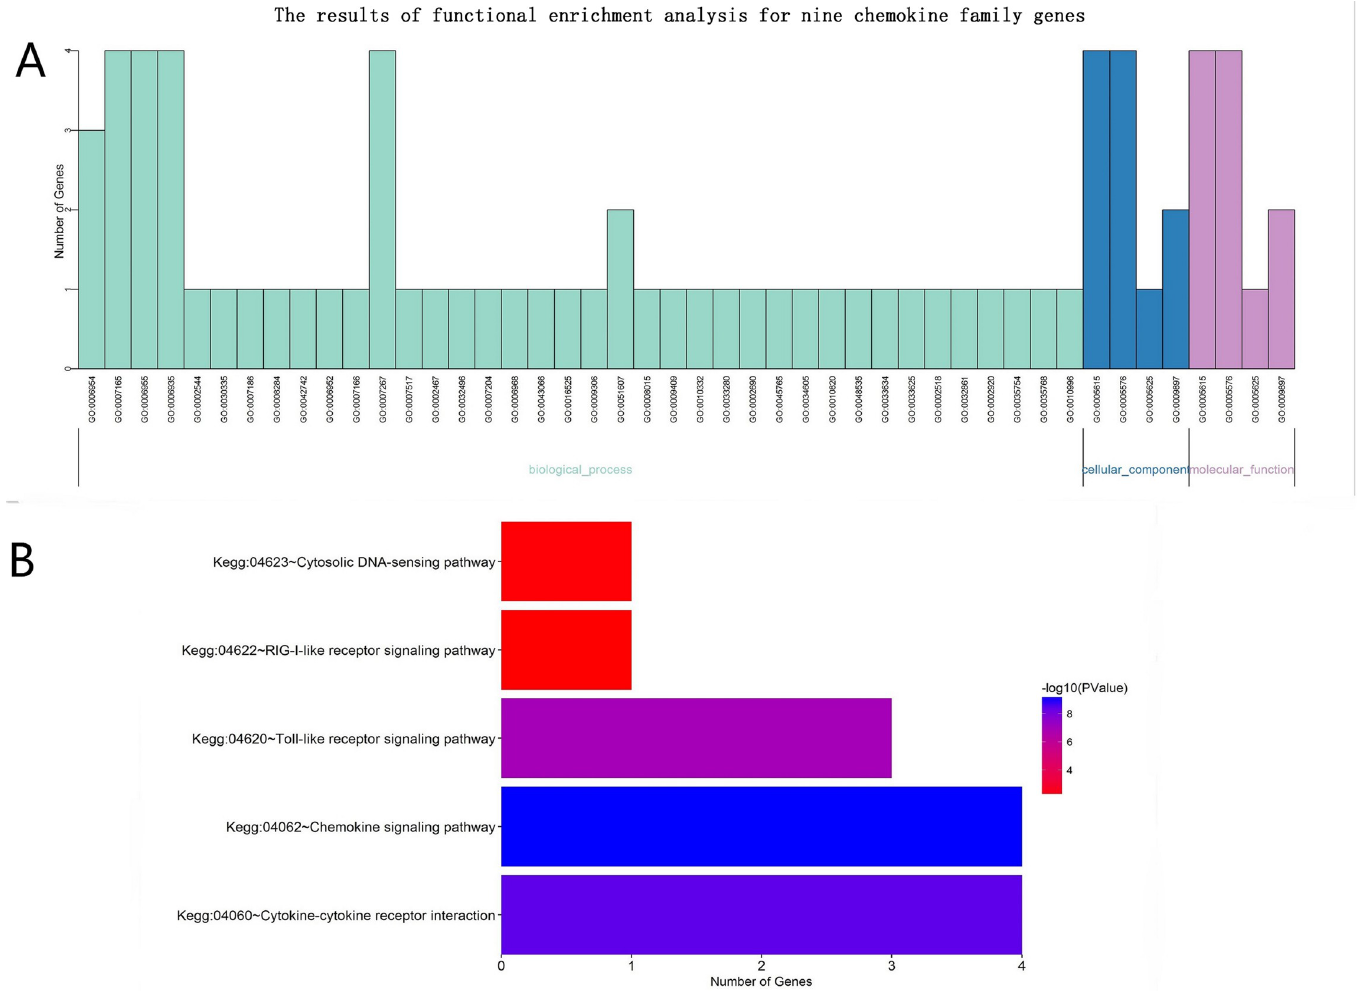
Fig 6. The results of functional enrichment analysis for nine chemokine family genes.